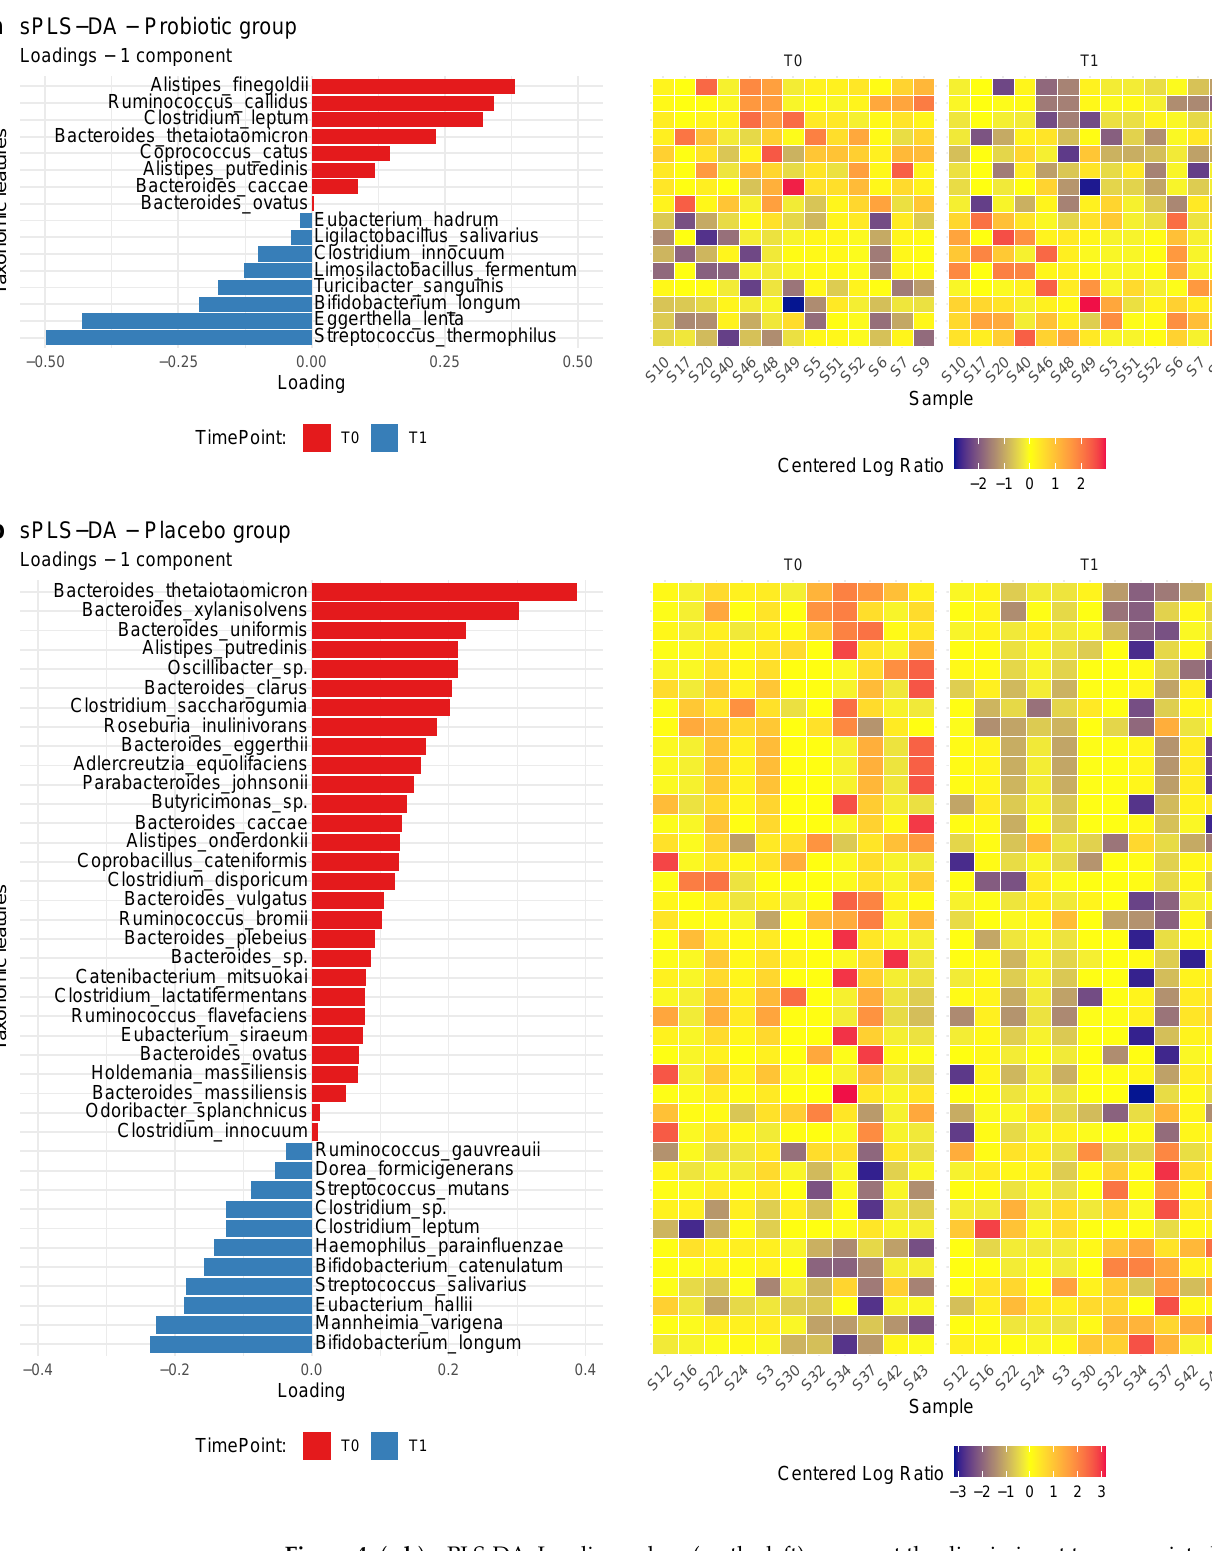
Figure 4. ( a , b ) . sPLS-DA. Loading values (on the left) represent the discriminant taxa associated with the samples at time point T0. The bigger the loading absolute value, the stronger the association. Heatmap (on the right) shows the CLR values of the discriminant taxa in all the samples. ( a ) Probiotic treatment group. ( b ) Placebo treatment